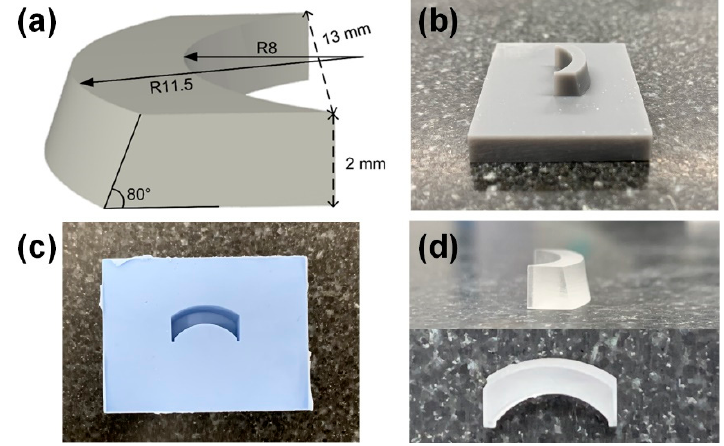
Figure 3. ( a ) Optical lens designed by a 3D CAD (Computer Aided Design) program; ( b ) positive optical lens mold constructed by using a 3D printer; ( c ) negative optical lens mold constructed by using Room-Temperature Vulcanizing (RTV), to fabricate the optical lens with the lens material, i.e., Epotek-301; and ( d ) completed optical lens of which inner and outer radii were 8 and 11.5 mm, respectively, and oblique angle was 80 ◦ .